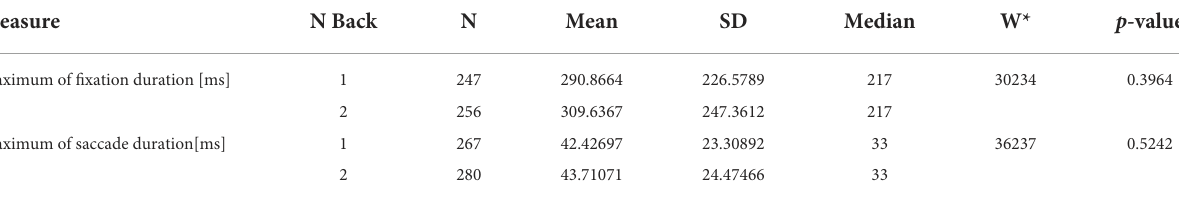
TABLE 7 The descriptive statistics and Mann–Whitney–Wilcoxon test results for the maximums of fixation duration between 1 and 2 back for all selected